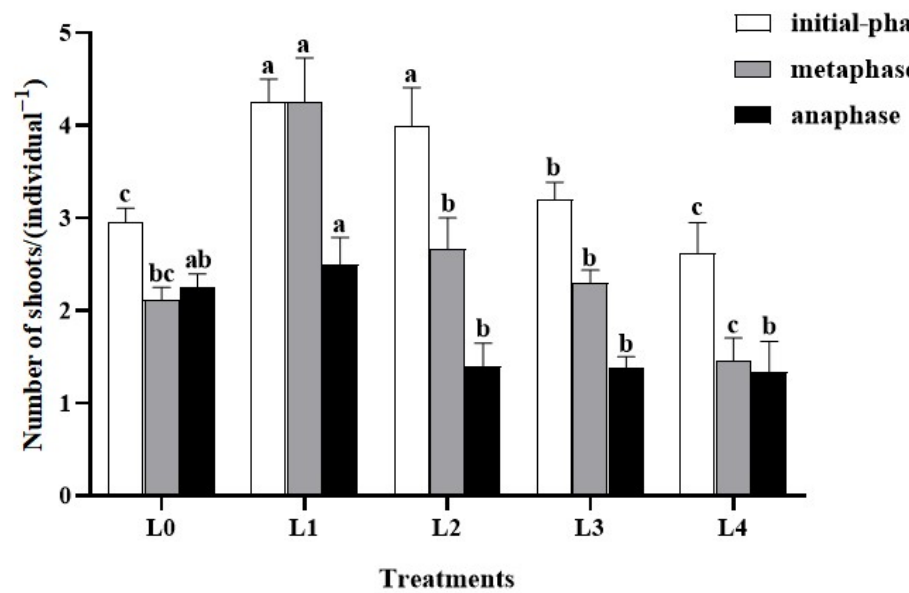
Figure 1. Effects of different light intensities on the number of germinated shoots for Ma bamboo. Note: L0, L1, L2, L3, and L4 refer to 100%, 40%, 30%, 20%, and 10% of natural light, respectively. Values are the means ± SE of eight replicates per treatment. Different letters indicate significant differences between treatments at the same shooting period ( p < 0.05).